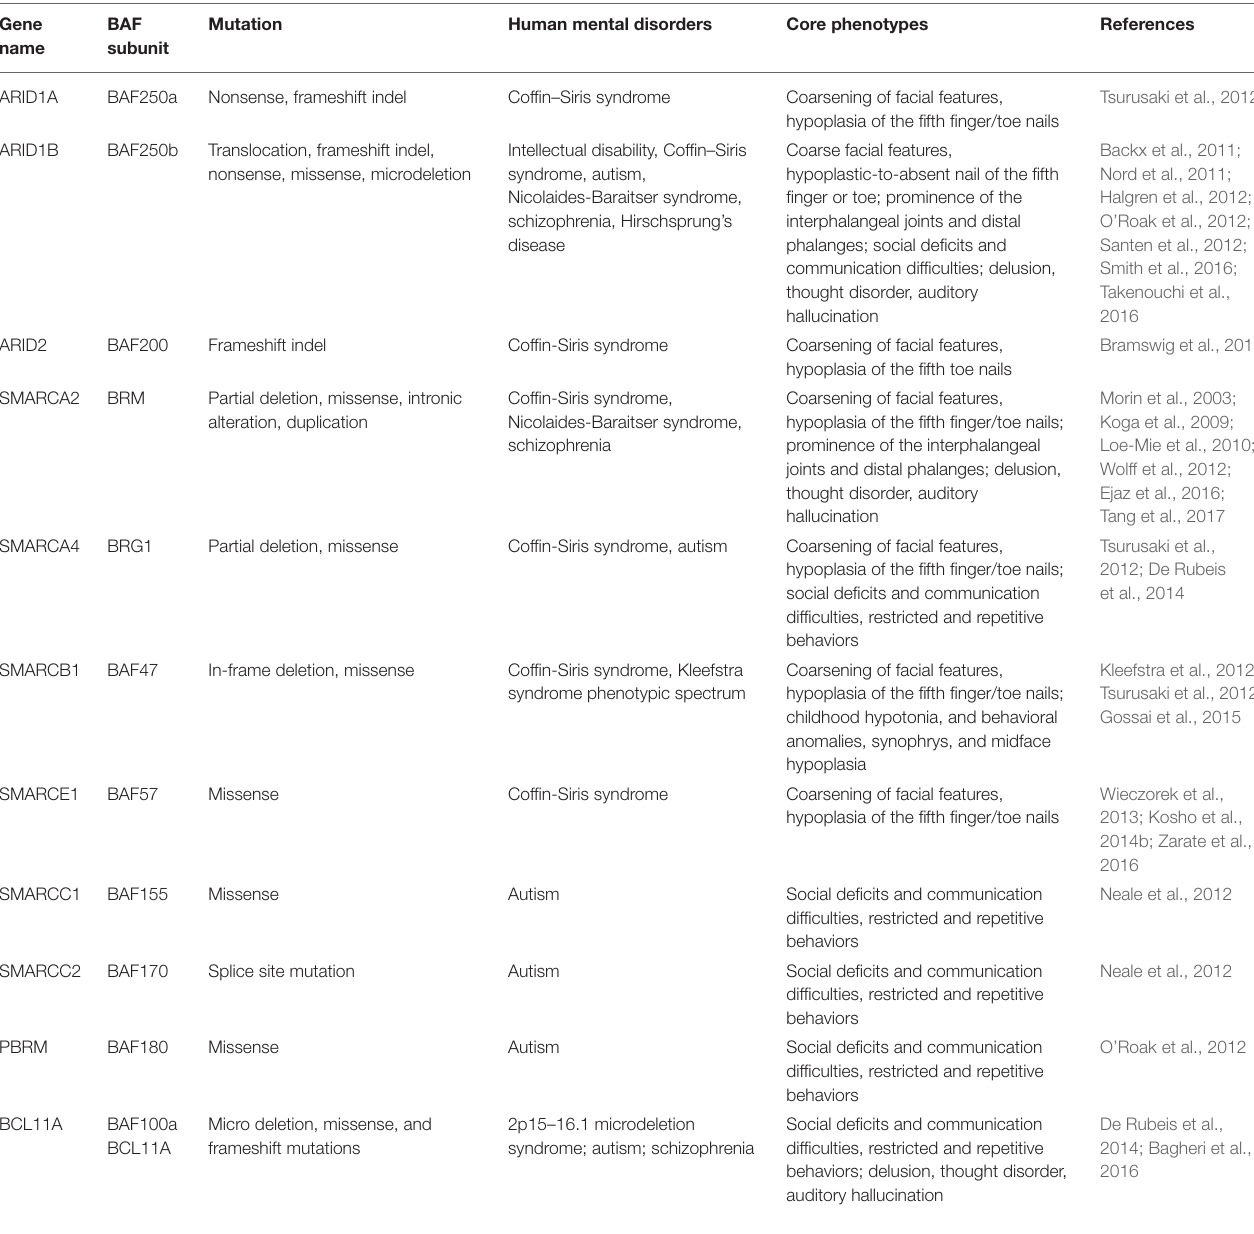
TABLE 2 | Mutated components of BAF complex in human mental